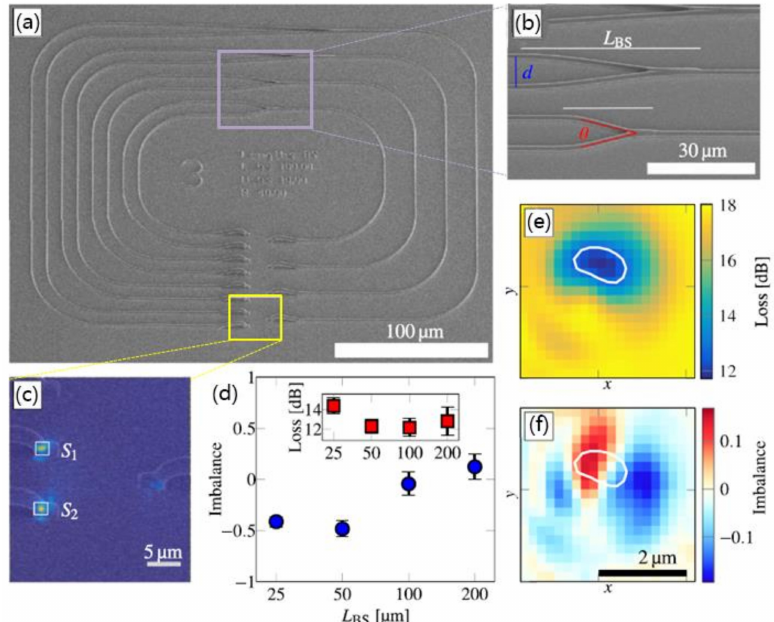
Figure 13. ( a , b ) The SEM image of the runway with several Y beam splitters with different separation lengths and the enlarged view of the Y area; ( c ) intensity distribution of the input and output at maximum transmission; ( d ) dependence between inbalance, insertion loss and separation length LBS; and the dimensional maps of ( e ) insertion loss and ( f ) imbalance of the longest waveguide shown as a function of the in-coupling position (x, y)